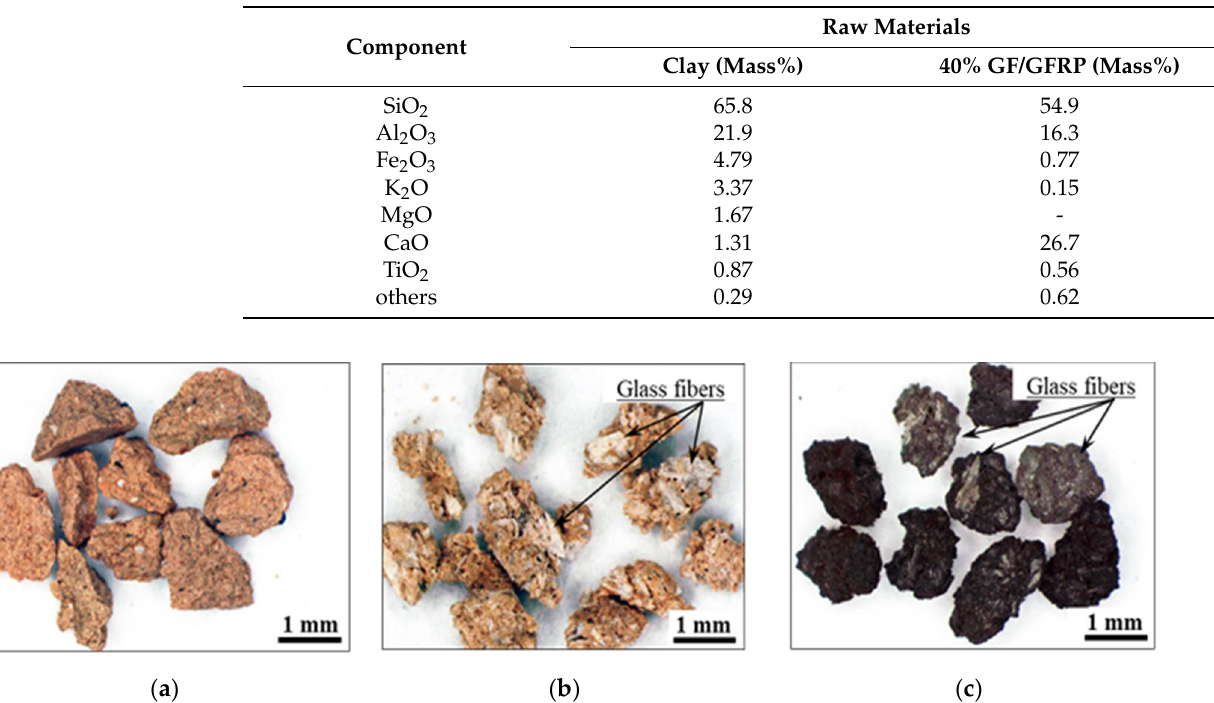
Figure 1. Manufacturing process of GFRP/clay ceramic samples used for the dye adsorption tests. Table 1. Compositions of inorganic substances in the clay and GFRP.